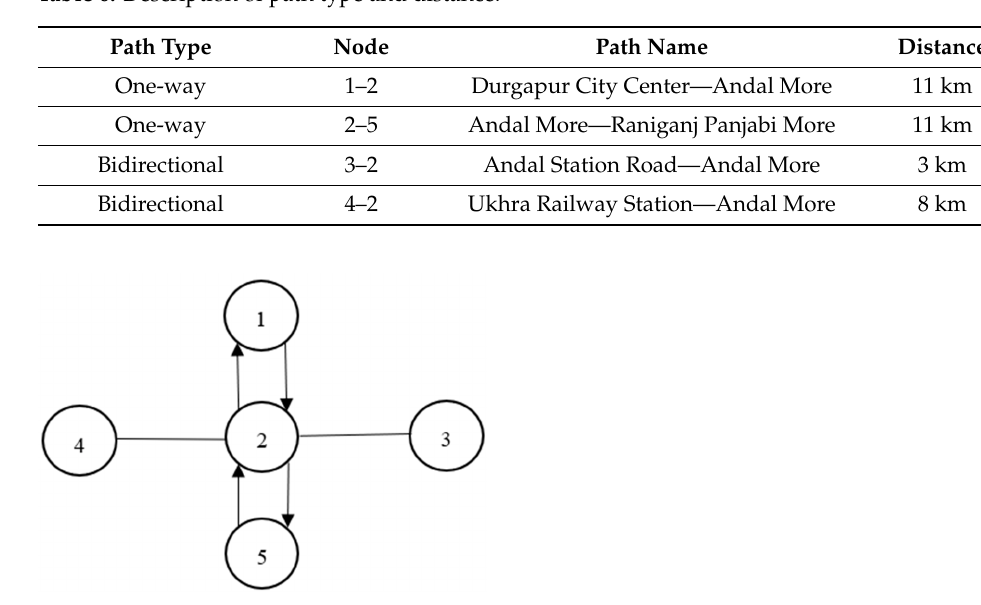
Table 6. Description of path type and distance.